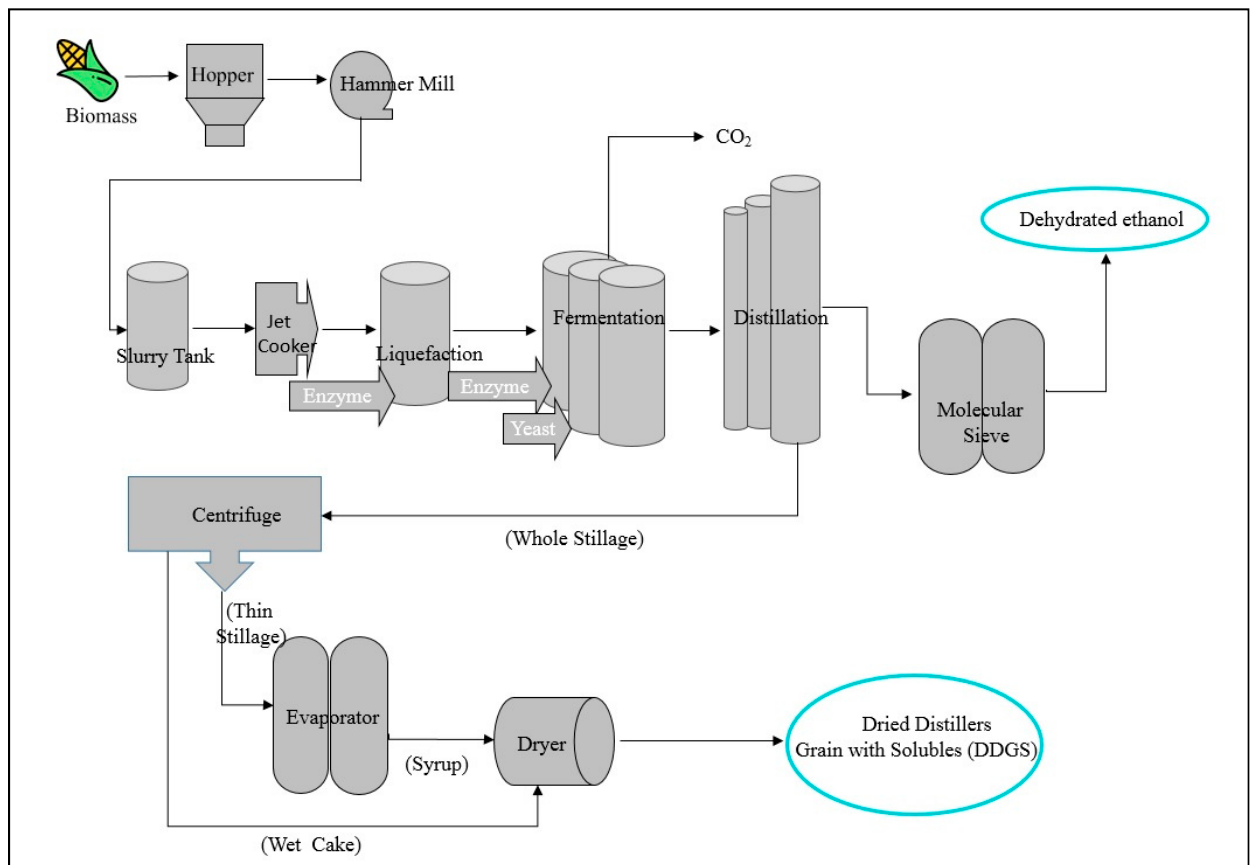
Figure 1. Schematic diagram of bioethanol production for first generation feedstock.